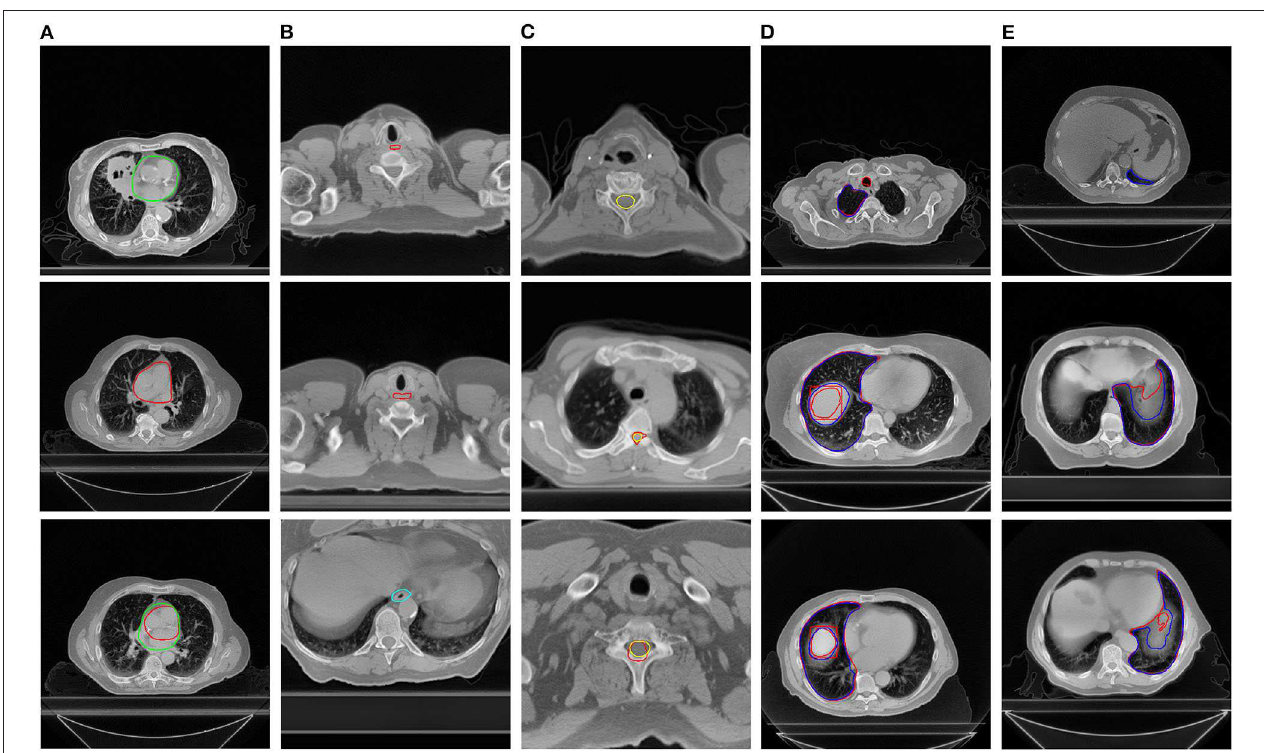
FIGURE 2 | Examples of errors detected by the quality assurance system. The manual contours are in red and the automatically generated contours are in other colors. The organs at risk from the first column to the fifth column are the heart (A) , esophagus (B) , spinal cord (C) , right lung (D) , and left lung (E) ,